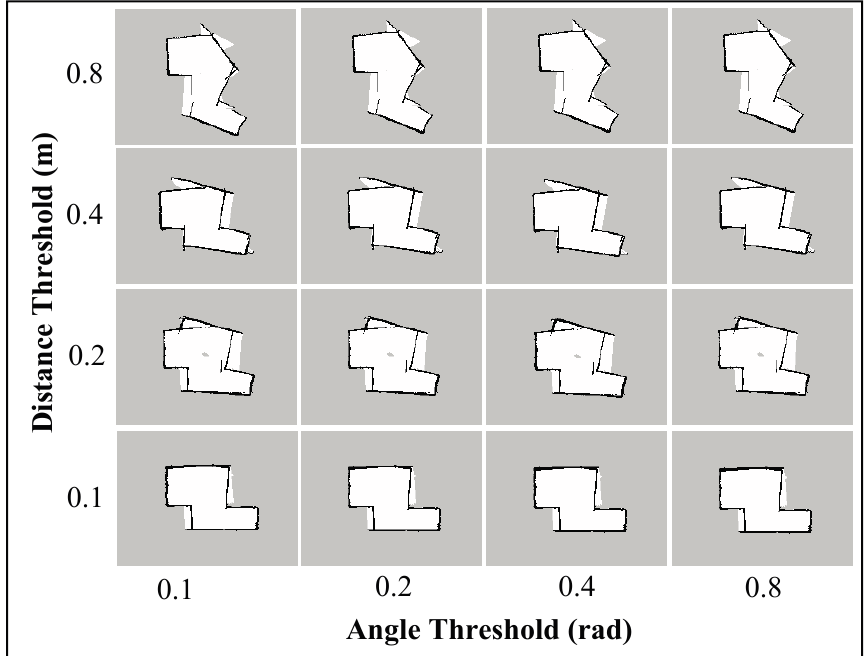
Figure 15. Room maps obtained using Hector SLAM technique with different combinations of Distance and Angle Threshold